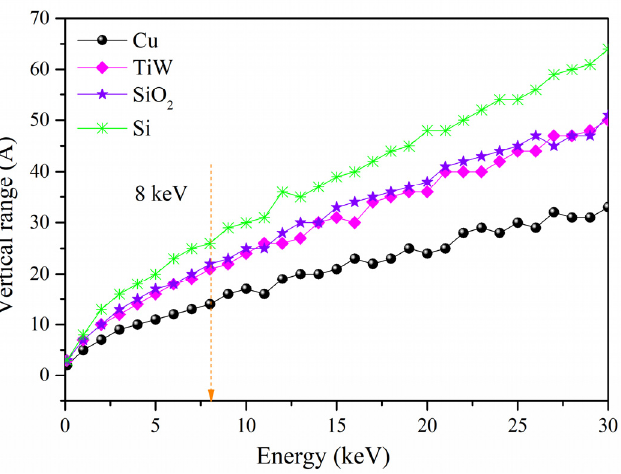
Figure 16. The maximum transverse deviations of Ga + in various materials with different energies.